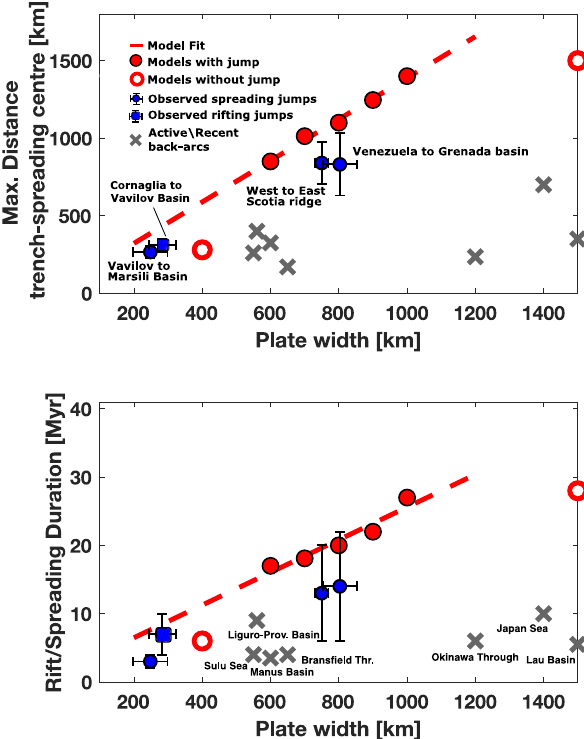
Fig. 4 Comparison to data. Comparison of models and observations of back-arc spreading with and without back-arc spreading jumps. Timing in the natural data comprises the entire rifting and spreading duration. a The largest distance between trench and back-arc spreading centre. b Spreading duration of back-arcs. For models without spreading centre jumps (non- fi lled red circles), we measure the spreading period of the fi rst back-arc. Models with back-arc spreading jumps form a linear trend, while the ones without spreading jumps plot below this trend. Observational data of back- arc spreading jumps plot close to the regression line, while all other active or recently inactive basins plot below